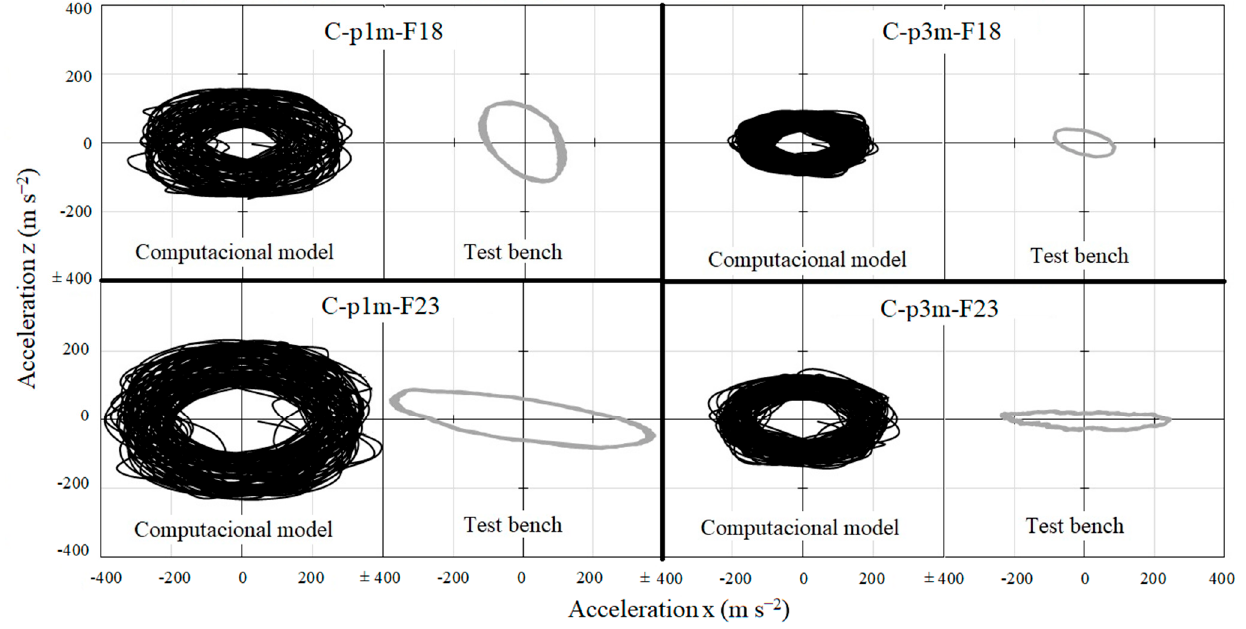
Figure 8. Orbits of accelerations recorded at Top of the post for the configurations considered.